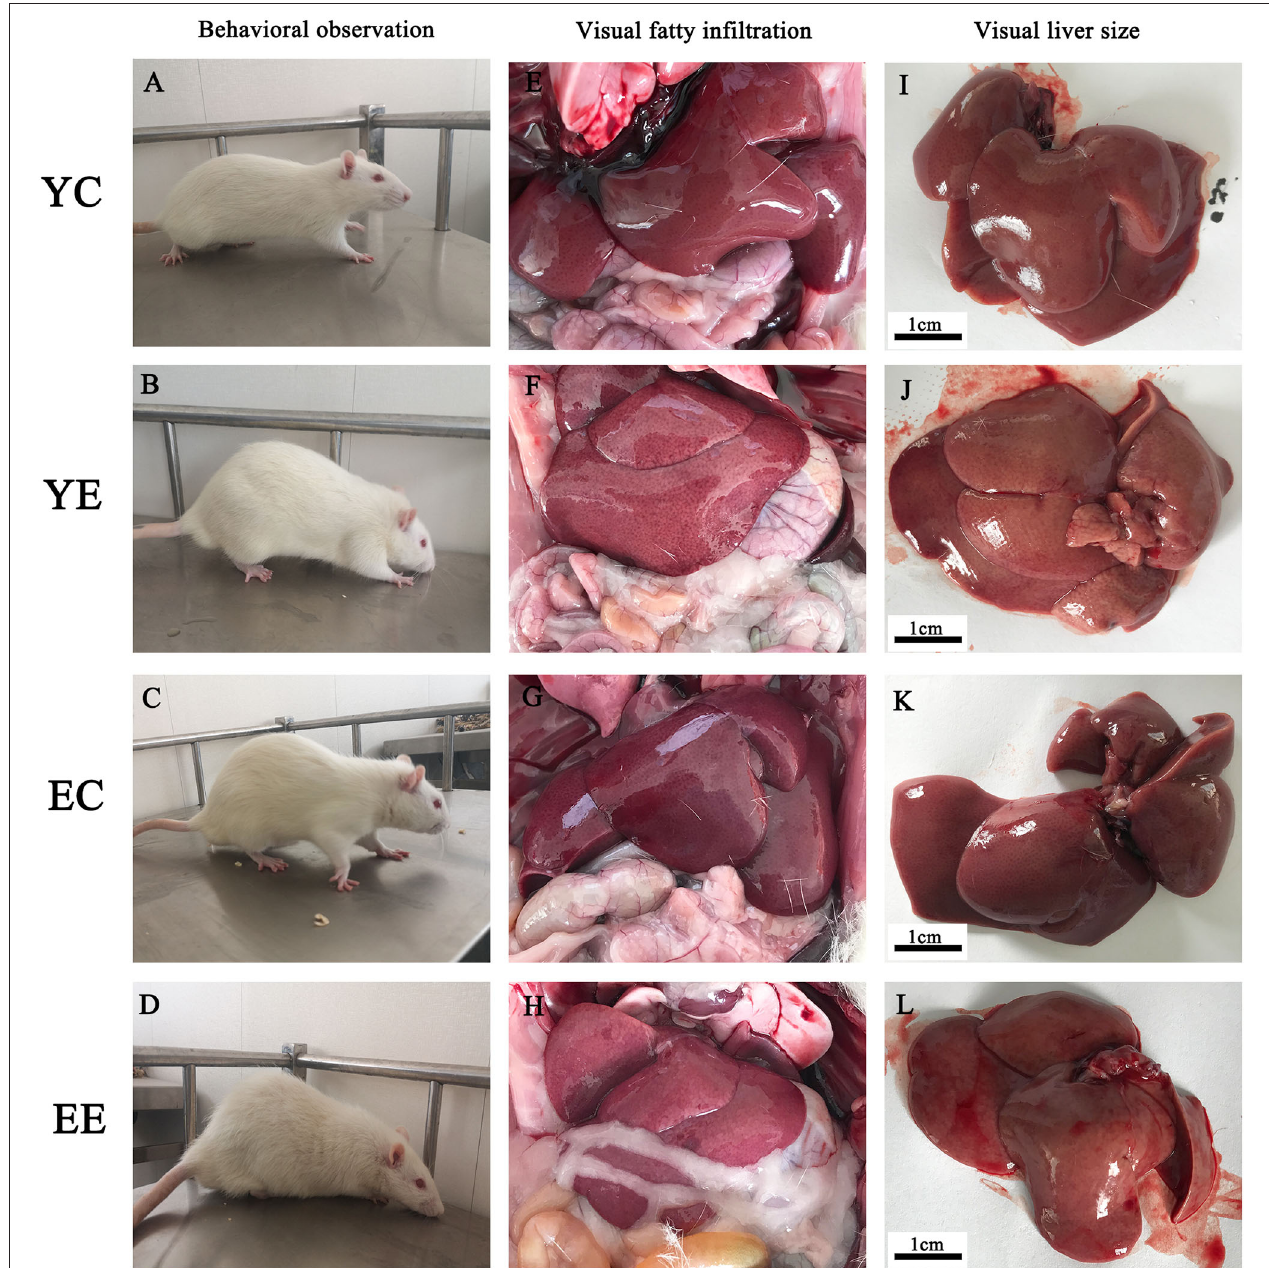
FIGURE 2 | Effect of HFD on behavior and liver of rats. Comparisons among YC, YE, EC, and EE rats in appearance (A–D) , liver in vivo (E–H) , and liver in vitro (I–L) . We found that Opa 1 protein in liver of YE group was significantly higher than that in EE group ( P < 0.01) ( Figure 6A ), and there was no significant difference in skeletal muscle ( P > 0.05) ( Figure 6B ). Mfn2 protein had no significant difference between YE group and EE group in liver ( P > 0.05) ( Figure 6C ), but the difference is significant in skeletal muscle ( P < 0.01) ( Figure 6D ). There was no significant difference in the expression of Drp 1 protein between the YE and EE groups in liver and skeletal muscle ( P > 0.05) ( Figures 6E,F